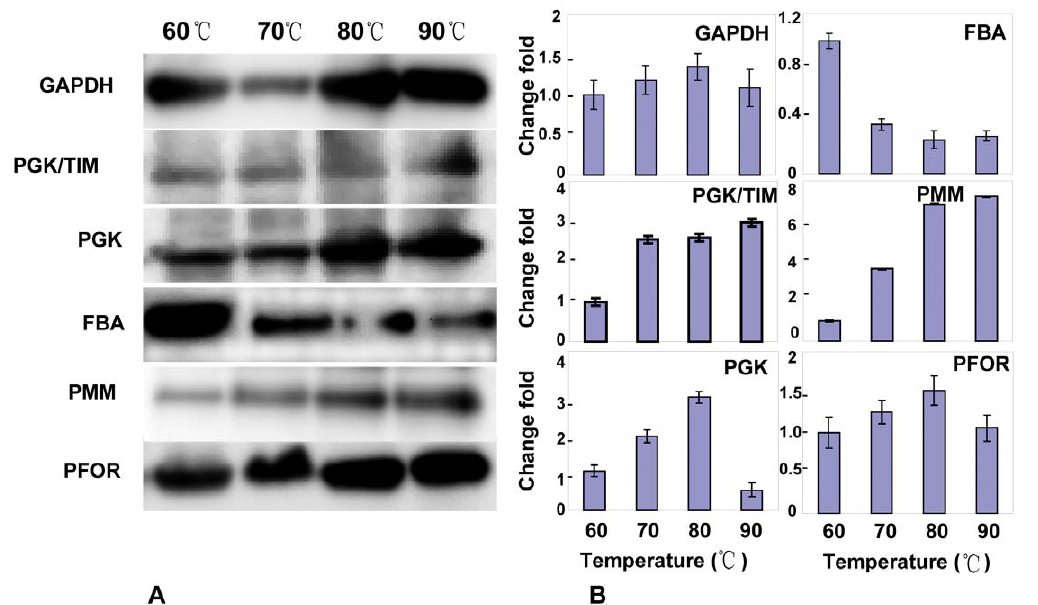
Figure 6. The temperature-dependent expression of the T.maritima carbohydrate metabolism related genes validated by Western blot and real-time PCR. A) The temperature-dependent proteins of central carbohydrate pathways in T. maritima were validated by Western blot. The six temperature-dependent proteins in T. maritima were specifically recognized by their correspondent antibodies at the four temperatures. B) The temperature-dependent expression of the T. maritima carbohydrate metabolism related genes were validated by real-time PCR. The experimental procedure and the statistic estimation for the parallel runs were described in ‘‘Material and Methods’’.